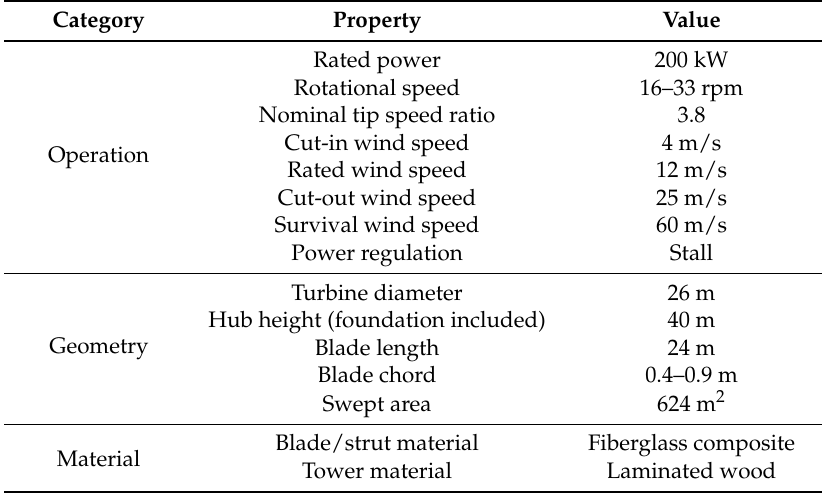
Table 1. Properties of the